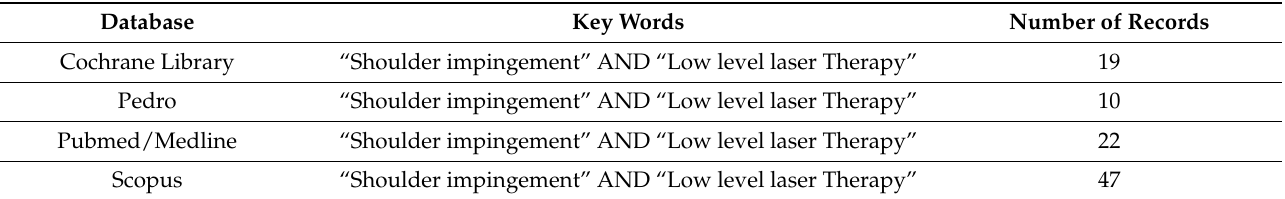
Table 1. Search strategy in different